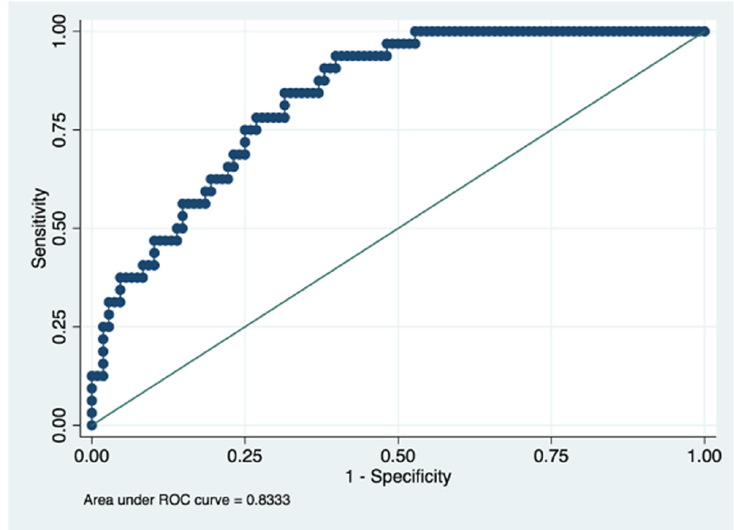
Figure 4. Predictive capacity for the cut-off point >40 points for the PDQ-39 questionnaire at two years. Figure legend. AUROC to determine the predictive ability of the model in the validation cohort, representing the sensitivity on the y-axis and specificity on the x-axis.